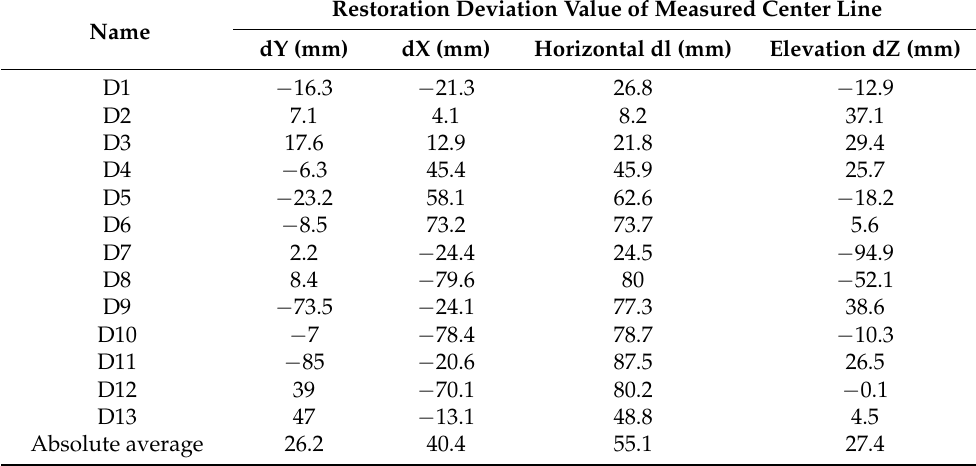
Table 6. Target error of restoration point cloud